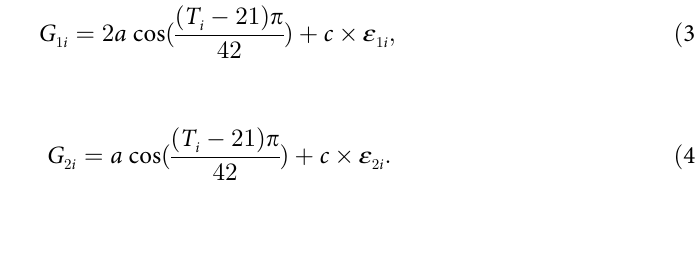
Table 1. Comparison of the six correlation measures on the nonlinear correlation between genes G 1 and G 2 , gen- erated by Eqs (1) and (2) with 100 replicates. c = 0.0 0.5 1.0 2.0 a = 0 False positive rates K c -poly2 a -- 0.28 0.24 0.27 K c -poly3 -- 0.30 0.45 0.52 K c -RBF ( γ = 0.5) -- 0.18 0.01 0.00 Pearson’s corr. b -- 0.00 0.00 0.00 Kendall’s corr. -- 0.00 0.00 0.00 Distance corr. -- 0.00 0.00 0.00 a = 1 True Positive rates K c -poly2 -- 1.00 0.88 0.47 K c -poly3 -- 1.00 0.96 0.69 K c -RBF ( γ = 0.5) -- 0.99 0.63 0.08 Pearson’s corr. -- 0.92 0.21 0.02 Kendall’s corr. -- 0.04 0.00 0.00 Distance corr. -- 0.92 0.33 0.04 Correlation measurement ( p -values) K c -poly2 1.00 ( < � a ) 0.99 ( < � ) 0.88 ( < � ) 0.47 (0.02) K c -poly3 1.00 ( < � ) 1.00 ( < � ) 0.96 ( < � ) 0.67 (0.001) K c -RBF ( γ = 0.5) 0.97 ( < � ) 0.92 ( < � ) 0.71 ( < � ) 0.32 (0.10) Pearson’s corr. 0.86 ( < � ) 0.78 ( < � ) 0.61 (0.004) 0.32 (0.10) Kendall’s corr. 0.65 (0.002) 0.57 (0.007) 0.43 (0.04) 0.20 (0.21) Distance corr. 0.84 ( < � ) 0.79 ( < � ) 0.65 (0.002) 0.47 (0.02) a K c -poly2, K c -poly3, and K c -RBF denote K c with the polynomial kernel of degree 2 and 3, and the RBF kernel, respectively. b The notation corr. and � denote correlation coefficient and 5 � 10 -4 , respectively.